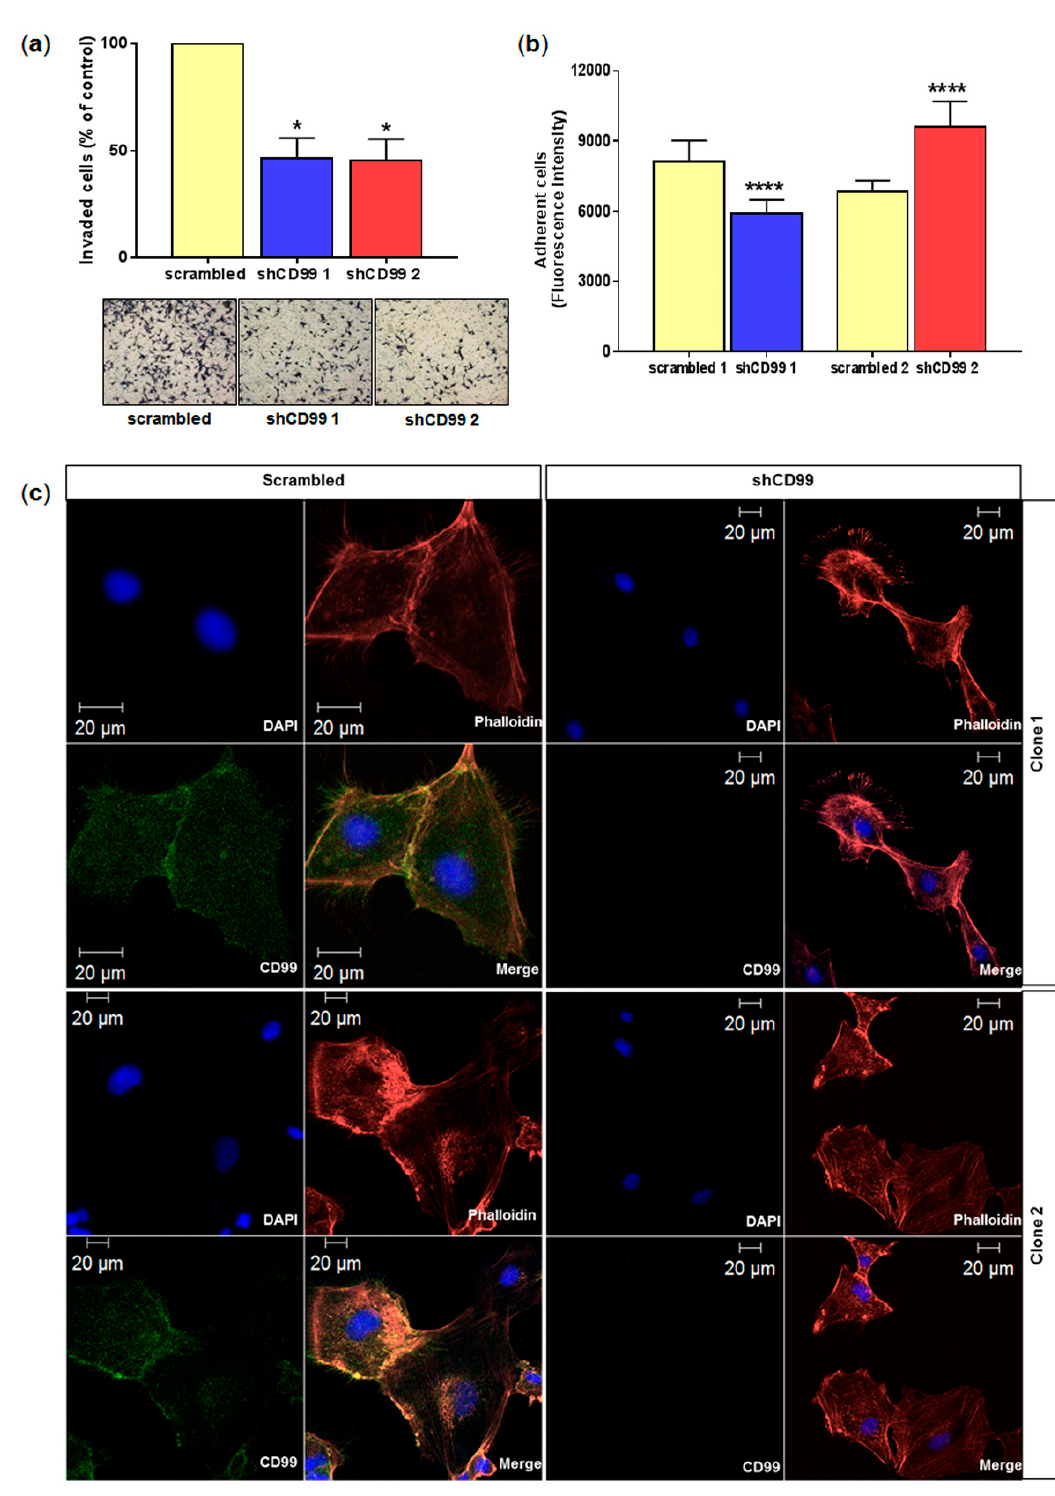
Figure 4. Role of CD99 in invasion and adhesion of the U87MG cell line, and colocalization of CD99 and phalloidin. ( a ) Trans-well invasion assay showing decreased U87MG invasion after CD99 knockdown (shCD99-1 and 2), when compared to the controls (scrambled). Graph represents percentage of invaded cells in relation to the control (means ± standard deviations of the means) in two independent experiments conducted in duplicate (* p < 0.05, Mann-Whitney test). The images show representative fields of U87MG cells that invaded and crossed the inserts (40x magnification). ( b ) Adhesion assay, with U87MG cells viability measurement by evaluation after 3 h of cell seeding onto the plate. The shCD99-1 U87MG cells attached less to the plate, while shCD99-2 U87MG cells